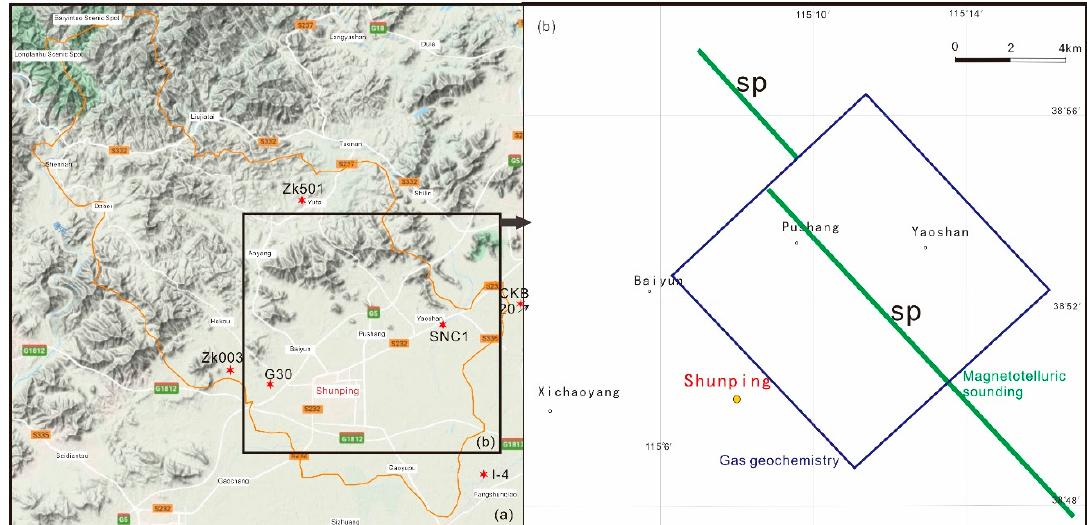
Figure 2. Location of the study area and geophysical geochemical survey.